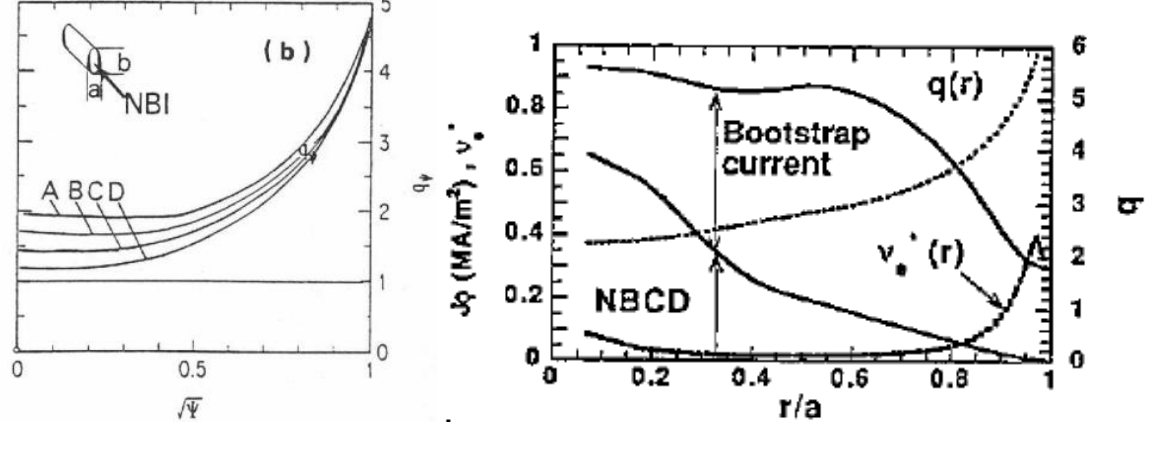
Figure 15. Weak shear operation scenarios using central current drive by high energy N-NBI by Kikuchi